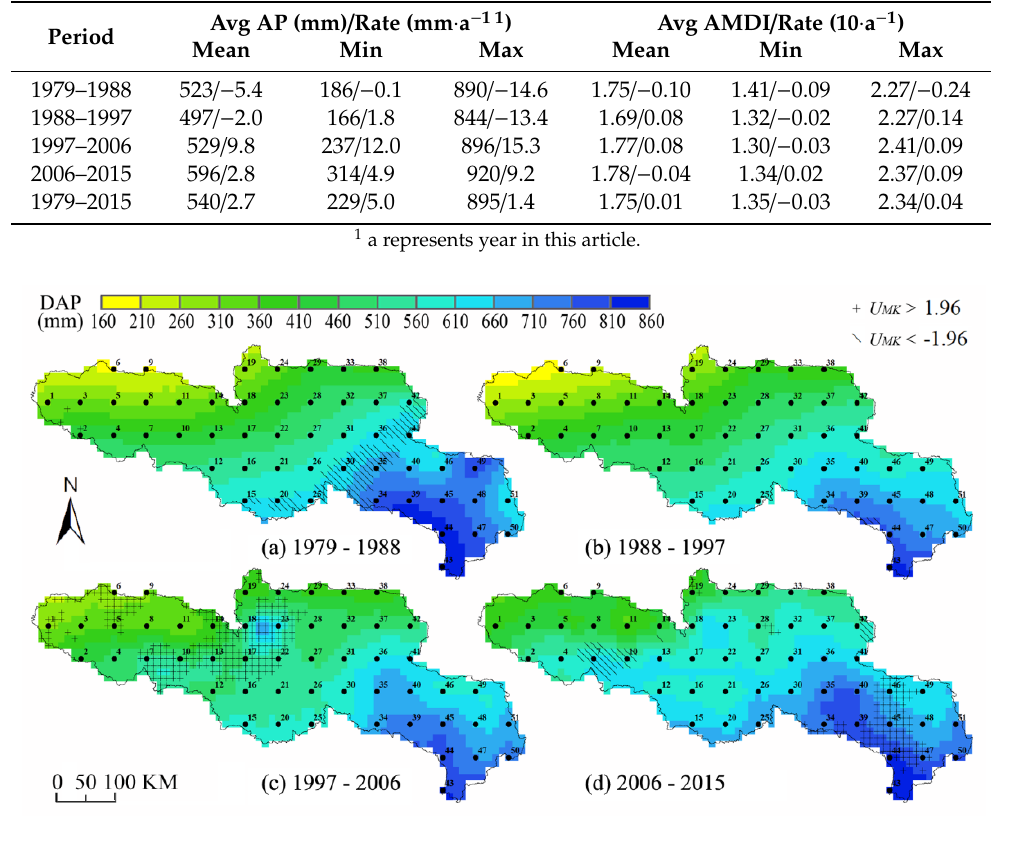
Figure 9. Average values and monotonic trends of annual precipitation over a decade for ( a ) 1979–